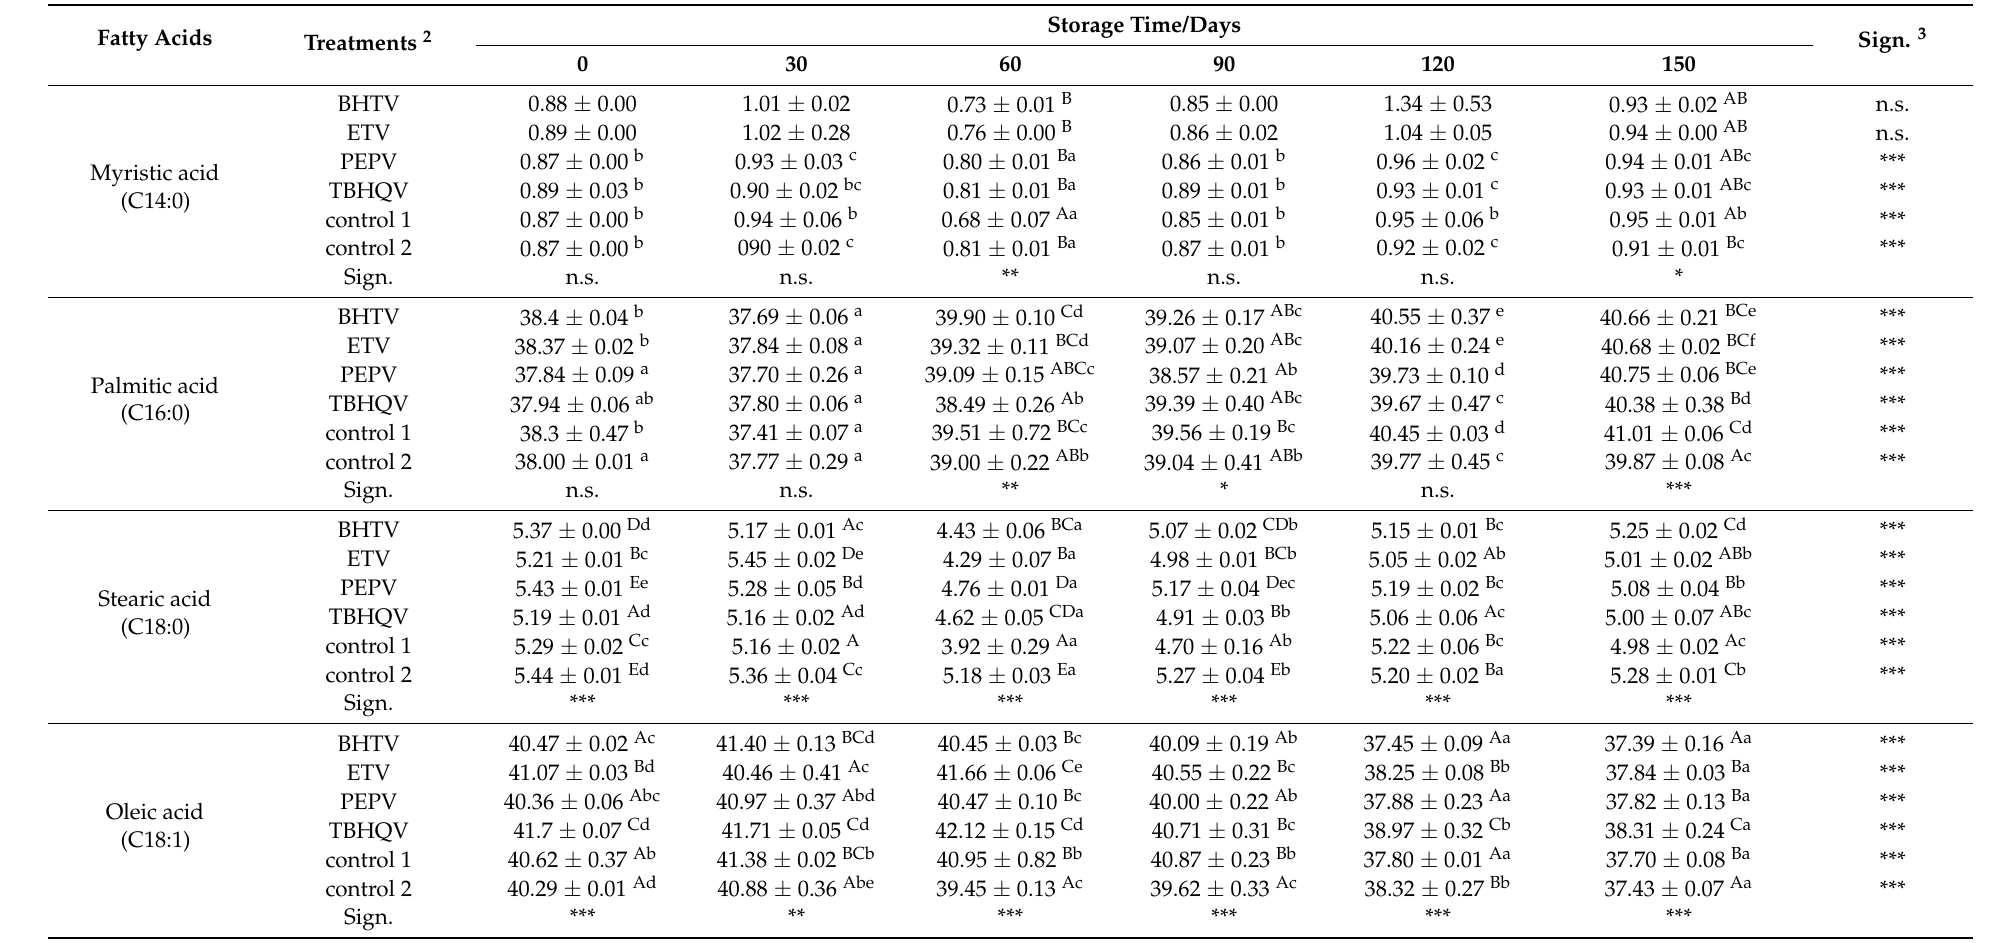
Table 2. Composition of fatty acids in deep fried Gryllus bimaculatus during storage (% of total fatty acids) 1 . Fatty